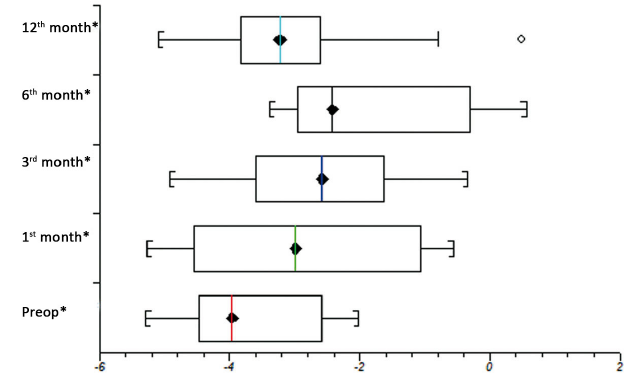
Fig. 8 - Evolution of z-scores for the subscapular skinfold/age (SSFAZ) in cardiac patients with SSFAZ in the preoperative period that was below the normal pattern of development. Analysis of variance with P=0.101. (*) The SSFAZ was significantly lower when compared with the general population’s in the preoperative period and in all follow-up months